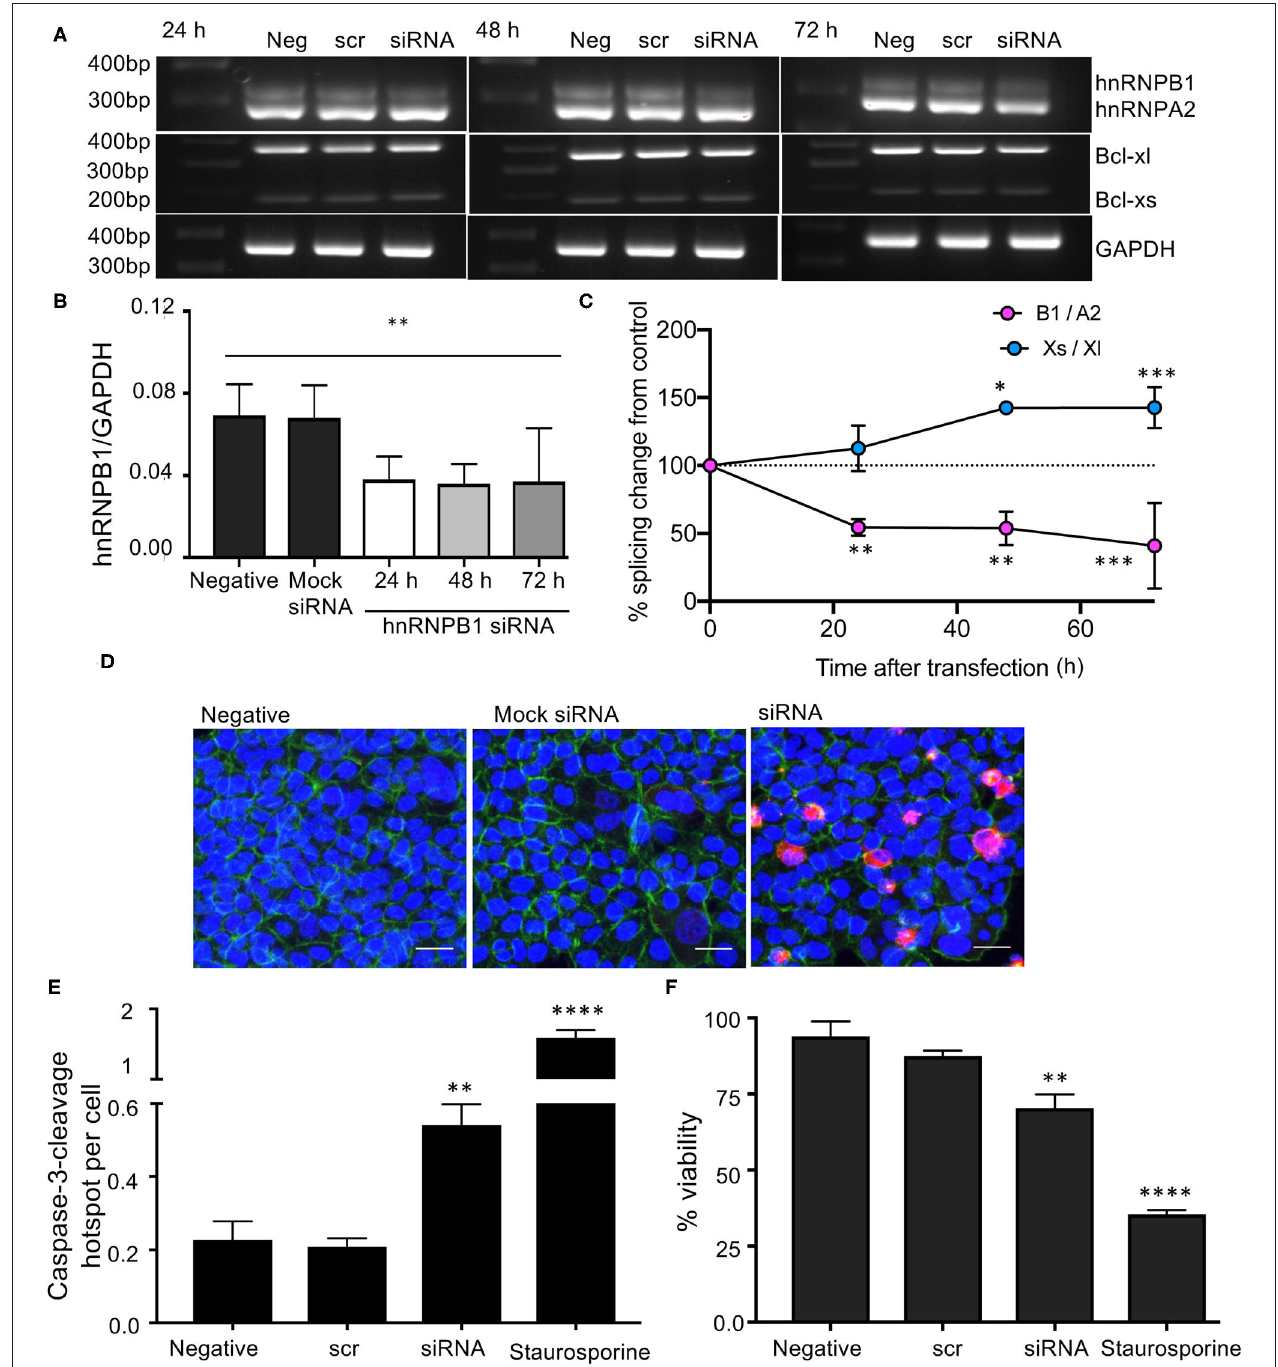
FIGURE 5 | Knockdown of hnRNPB1 and its effects on splicing of BCL2L1 in HCT116 colon cancer cells. (A) Cells were transfected with 2 µ g hnRNPB1 siRNA for 24, 48, and 72h then RNA was extracted and subjected to RT-PCR. (B,C) Quantification of splice variant expression demonstrated a decrease in hnRNB1, and an increase in Bcl-xs ( n = 3, mean ± SEM), (D) Increased caspase-3-cleavage and decreased cell viability in HCT-116 cells transfected with 2 µ g hnRNPB1 siRNA for 48h. Staurosporine was used as a positive control. DAPI (blue), phalloidin (green), and a Caspase-3-cleavage antibody (CCA) (red). Scale bar = 25 µ m. (E) Quantification of the number of cells positive for cleaved caspase-3 mean ± SEM ( n = 3). (F) Cell viability. For statistical analysis, One-way ANOVA with Dunnett’s multiple comparison test and post-hoc test for trend was used, * P < 0.1, ** P < 0.01, *** P < 0.001, **** P < 0.0001.